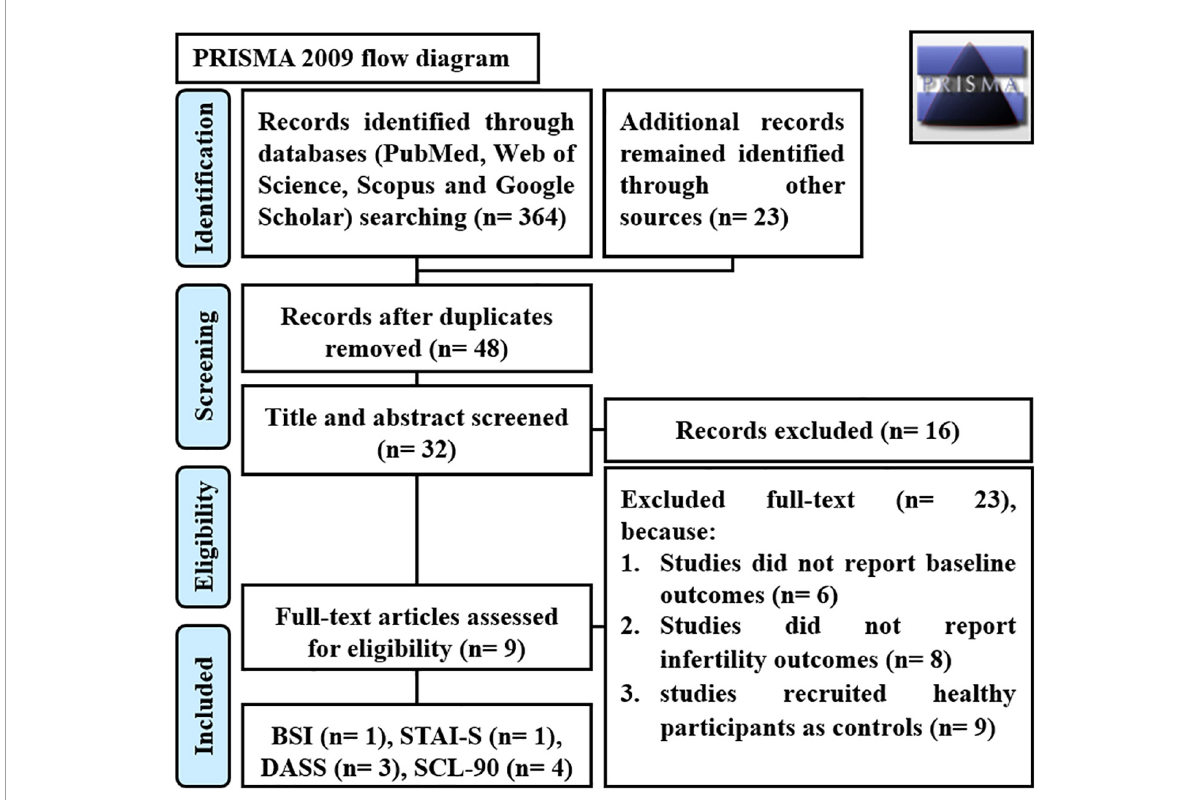
FIGURE2 PRISMA flow diagram. SCL90 Symptom Checklist 90, BSI Brief Symptom Inventory, STAI State-Trait Anxiety Inventory Form, and DASS Depression Anxiety Stress